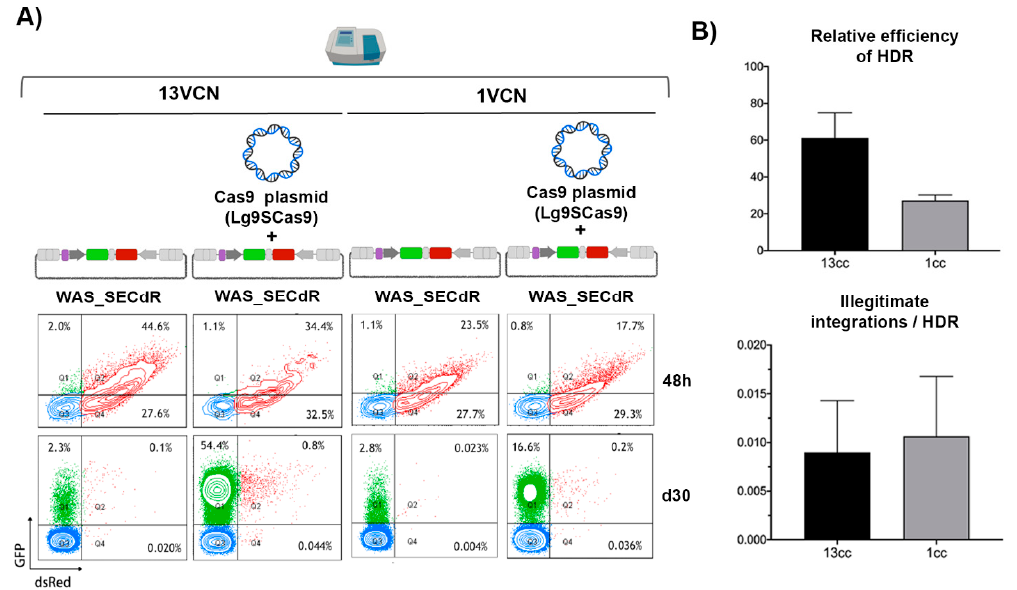
Figure 6. Correlation of the e ffi cacy of GE with the frequency of target sites. ( A ) Representative cytometry plots showing the expression of eGFP and dsREDon 13-K562GWP cells (13VCN) and 1-K562GWP (1VCN) over time. Reporter cells were nucleofected with WAS_SECdR donor alone or together with the Lg9SCas9 plasmid as indicated in the figure and the percentage of eGFP and dsRED expressing cells were determined 48 h (top plots) and 30 days (bottom plots) post-nucleofection. ( B ) Graphs showing the relative HDR e ffi cacy (top) and specificity (bottom) of HDR for 13-K562GWP cells (13cc) and 1-K562GWP (1cc) reporter cells. The relative e ffi cacy of HDR was calculated by dividing the % of eGFP + dsRED- cells (on-target HDR) at day 30 by the % of double positive cells at 48 h (initial transfection e ffi cacy). The frequency of illegitimate integration is shown related to the e ffi cacy of HDR. Values represent the mean of three separate experiments and the error bars indicate the standard errors of the mean. The comparison between the di ff erent groups was carried out using the Mann–Whitney U test (* p <